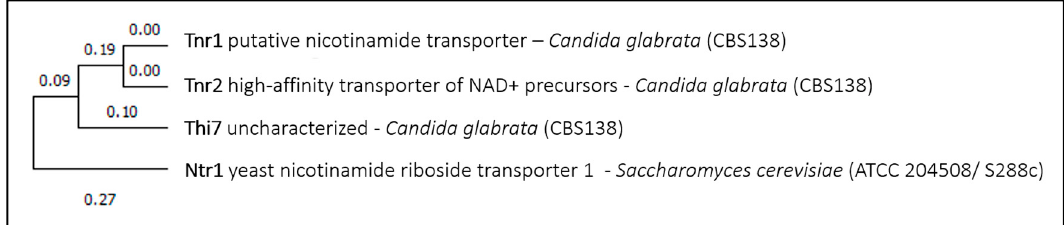
Figure 2. Nrt1 phylogenetic analysis. The tree with the highest log likelihood is shown. This analysis involved four amino acid sequences. There were a total of 596 positions in the final dataset. Evolutionary analyses were conducted in MEGA X.